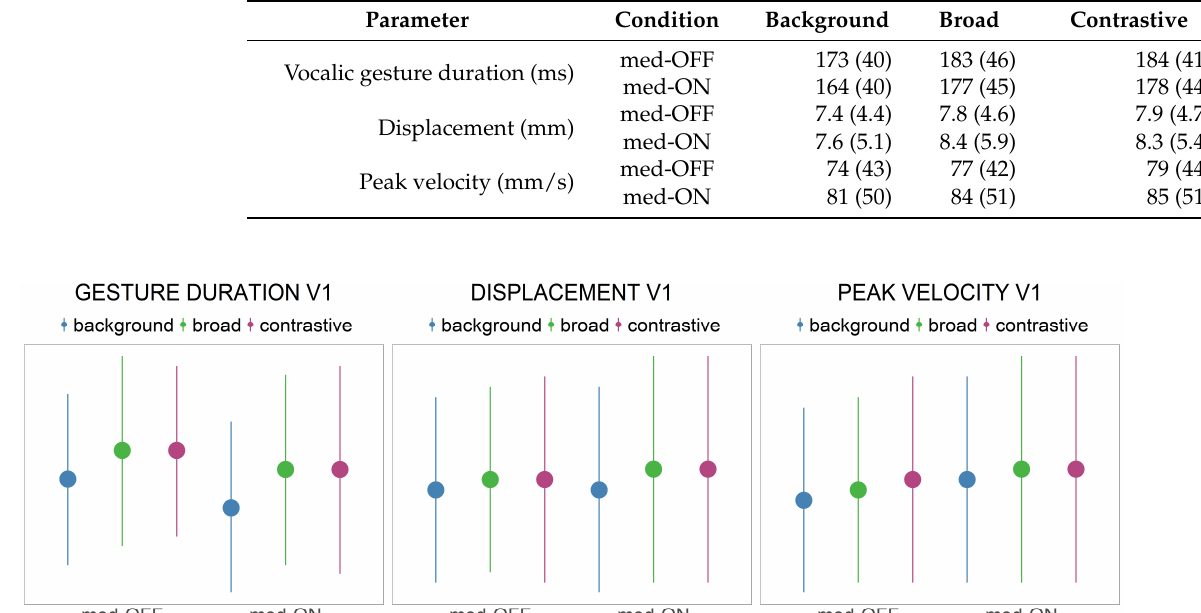
Figure 7. Presentation of z-transformed values (mean and sd) of articulatory measurements depending on medication condition and prominence condition.